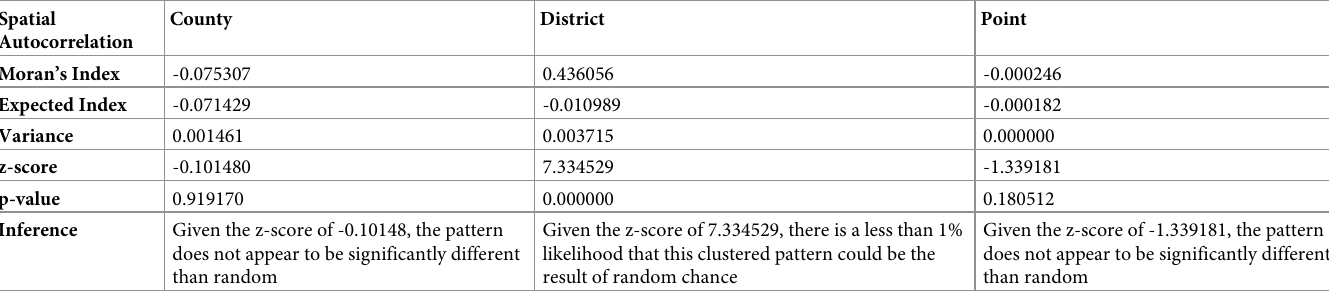
Table 2. Assessment of spatial pattern in the distribution of COVID-19 cases in Liberia, March 15, 2020 to July 31, 2021. Spatial County Autocorrelation